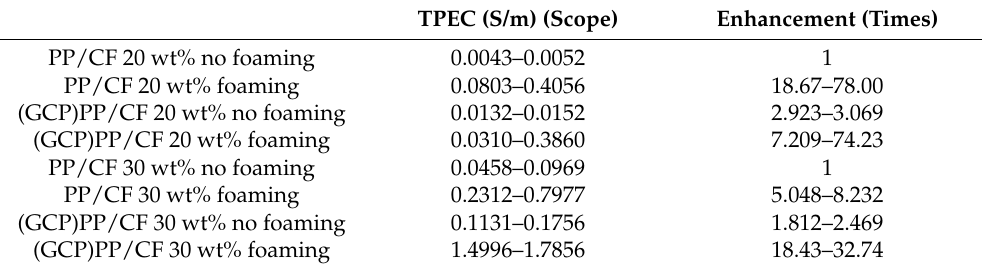
Table 4. Comparisons of TPECs of samples molded with different processing techniques.